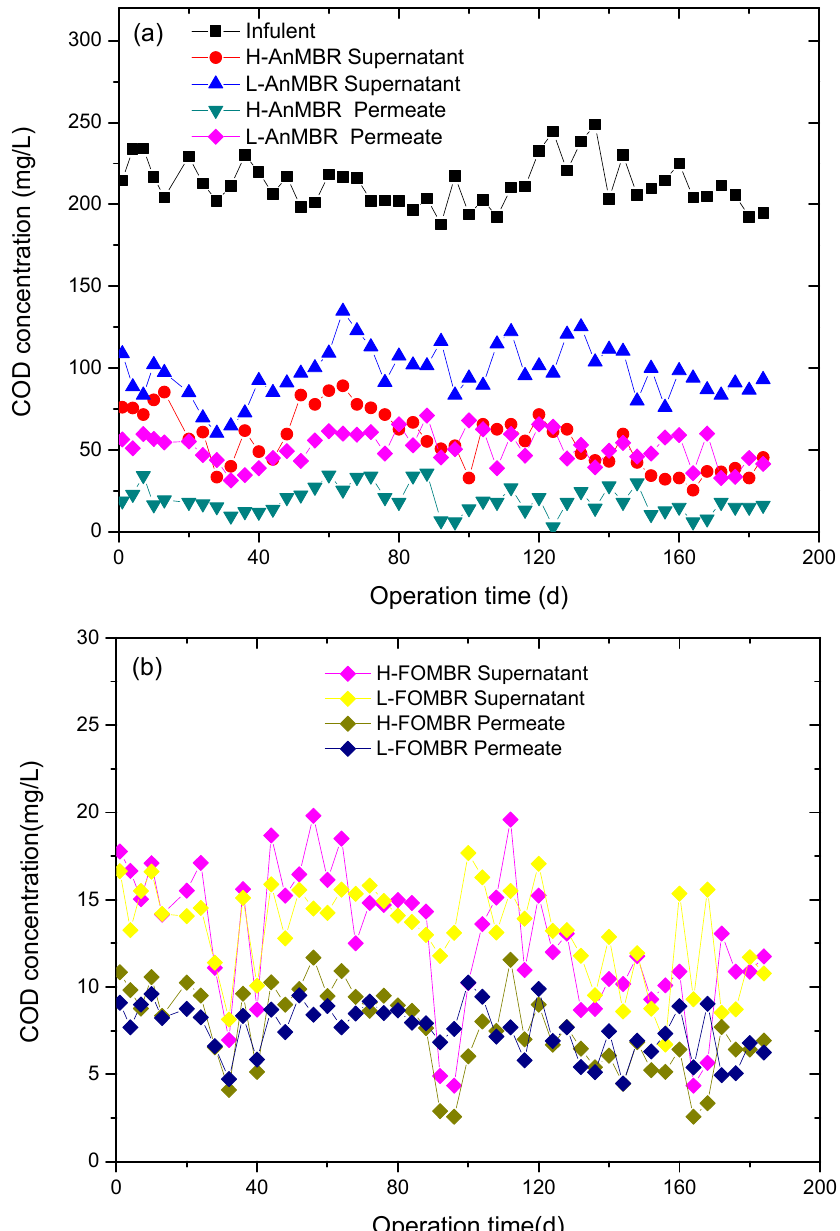
Figure 4. The chemical oxygen demand (COD) concentrations in the influent, supernatant and permeate during the whole operation period in the H-AnMBR and L-AnMBR ( a ) and the H-FOMBR and L-FOMBR ( b ).